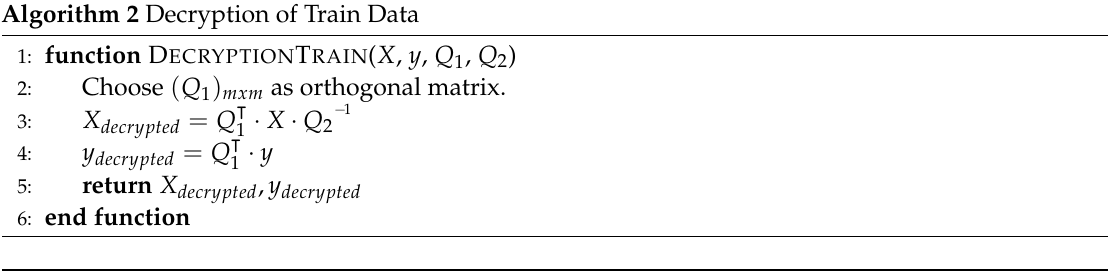
Algorithm 3 Encryption of Test Data